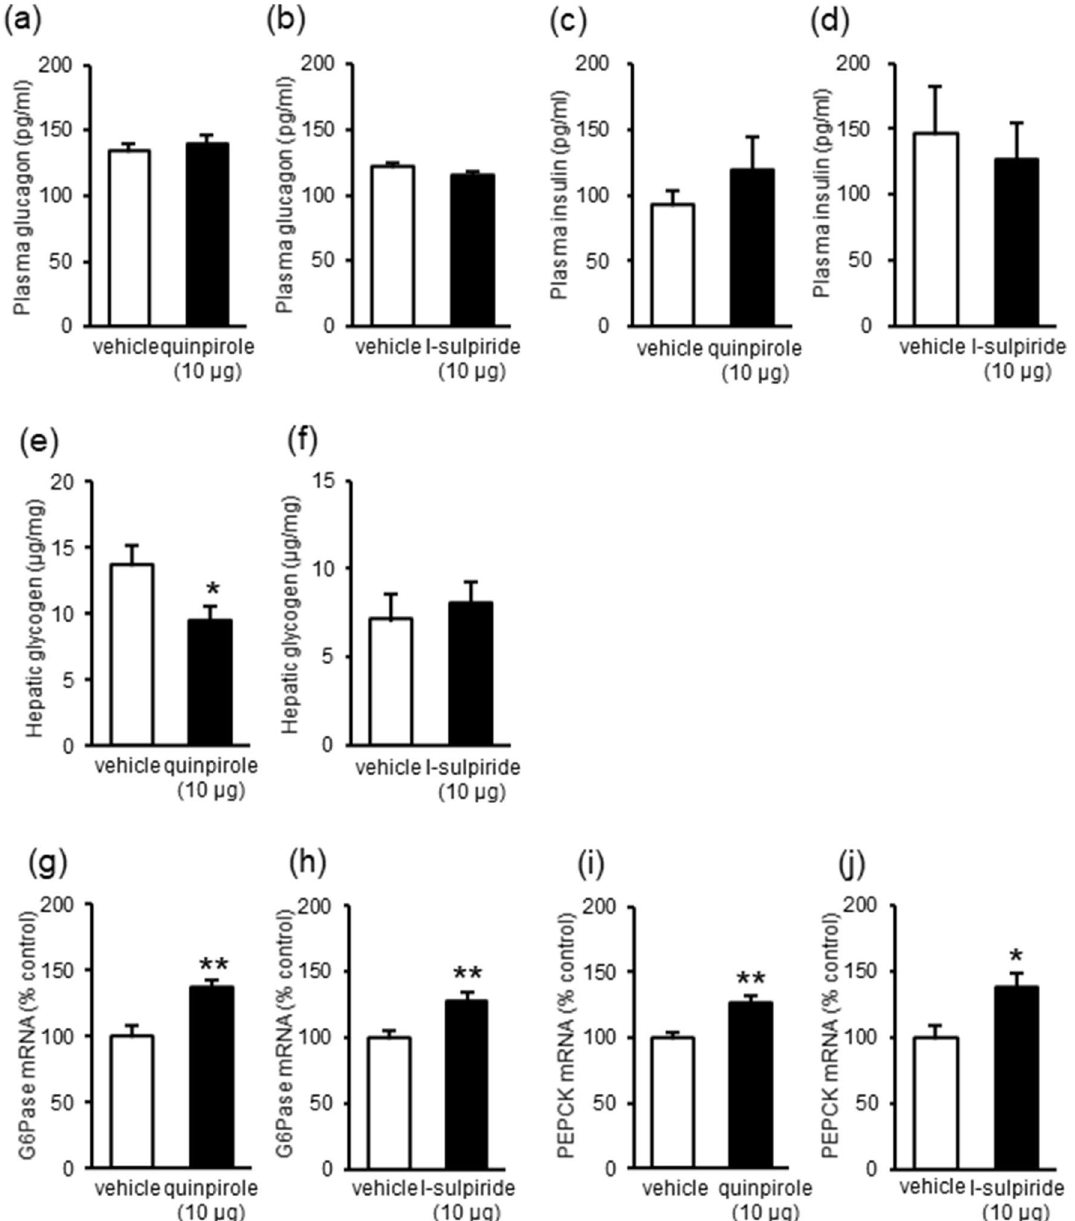
glucagon ( a , b ) and insulin ( c , d ) levels. Blood samples were collected 10 min after drug injections. ( e , f ) Effect of quinpirole (10 μg, i.c.v.; e ) and l-sulpiride (10 μg, i.c.v.; f ) on hepatic glycogen levels. Liver samples were collected 30 min after drug injections. ( g – j ) Effect of quinpirole (10 μg, i.c.v.; g , i ) and l-sulpiride (10 μg, i.c.v.; h , j ) on hepatic mRNA levels of glucose-6-phosphatase (G6Pase; g , h ) and phosphoenolpyruvate carboxykinase (PEPCK; i , j ). Liver samples were collected 30 min after drug injections. Each point represents the mean ± S.E.M. of 6–14 mice. * P < 0.05, ** P < 0.01 vs. vehicle